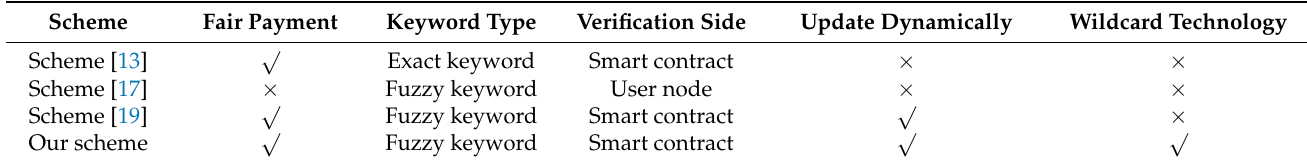
Table 2. Function comparison.